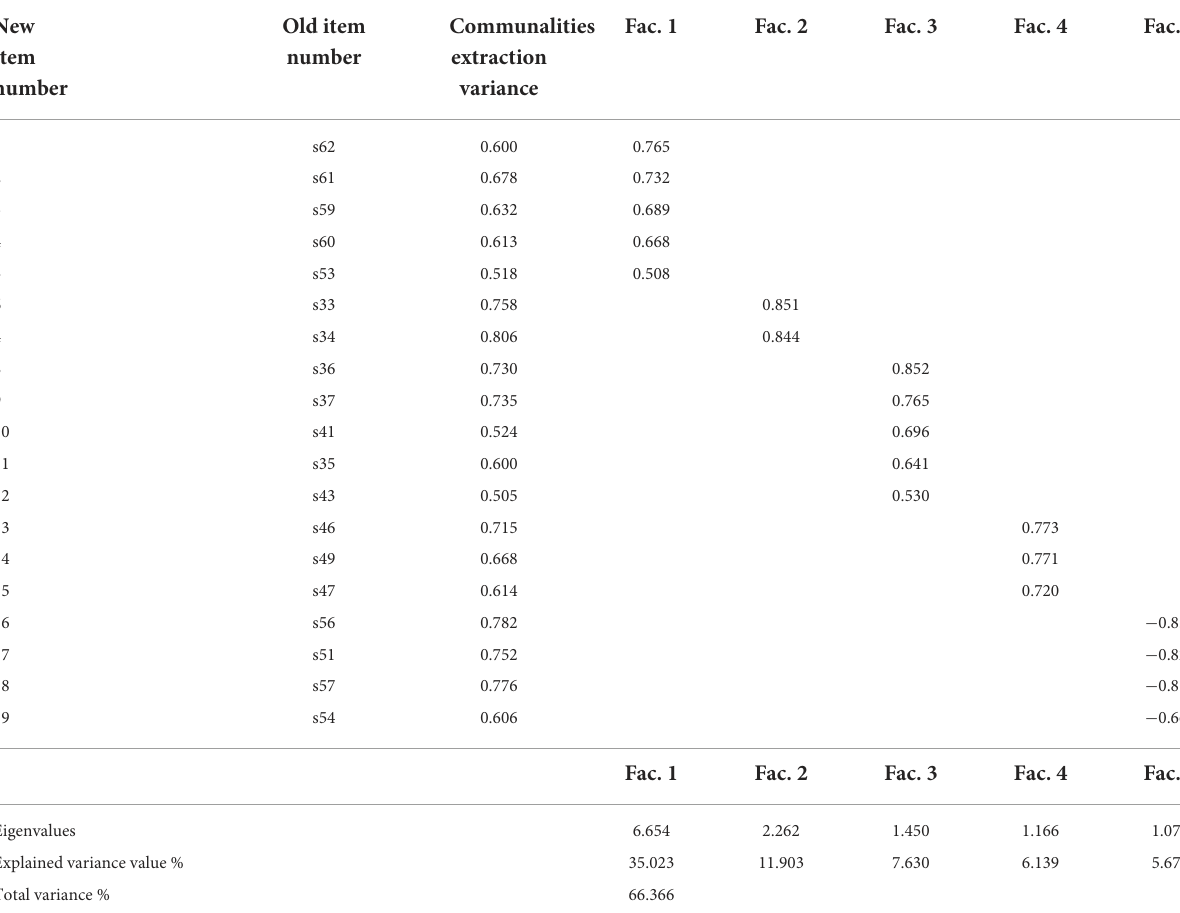
TABLE 2 Distribution of the scale by factors, item factor loads and factor variances.